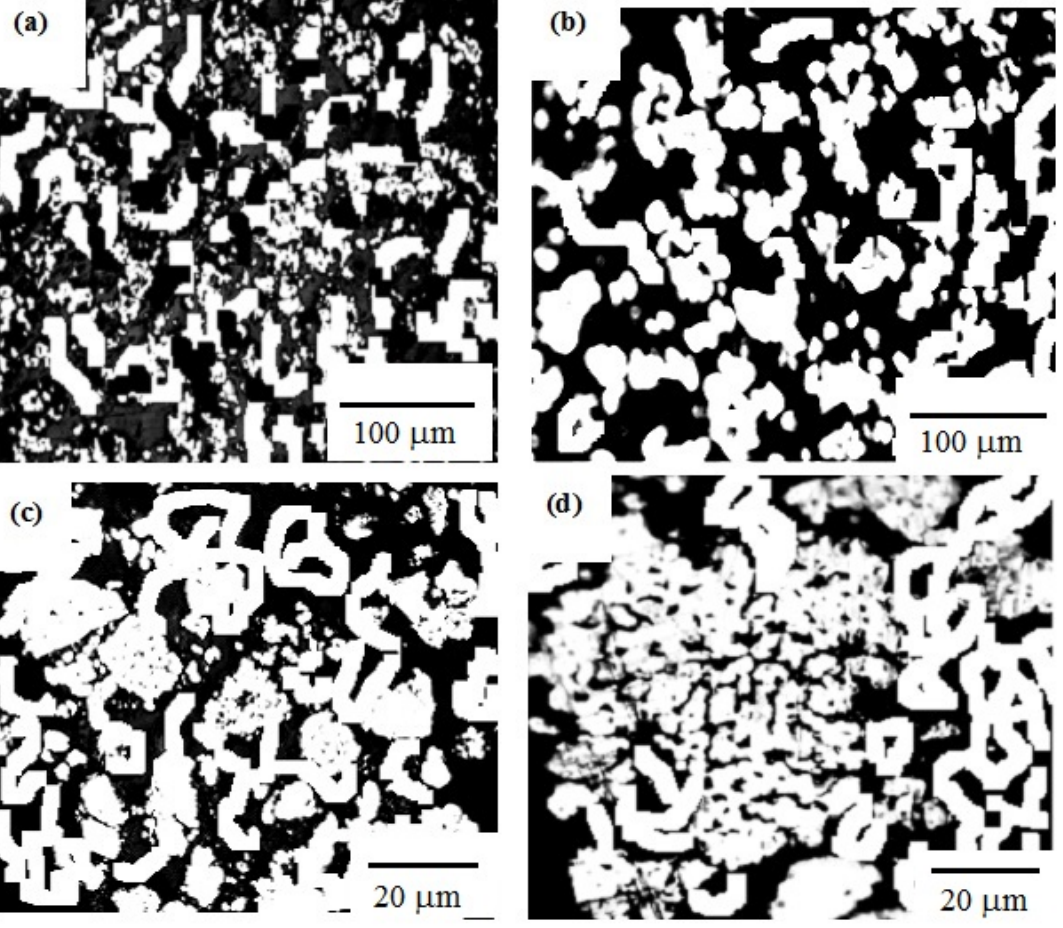
Figure 16. RLM photomicrograph of Fe 2 O 3 -charcoal composite reduced up to 1100 °C at different heating rates: ( a ) 20 o C/min, ( b )10 °C/min, ( c ) 15 °C/min and ( d ) 5 °C/min.